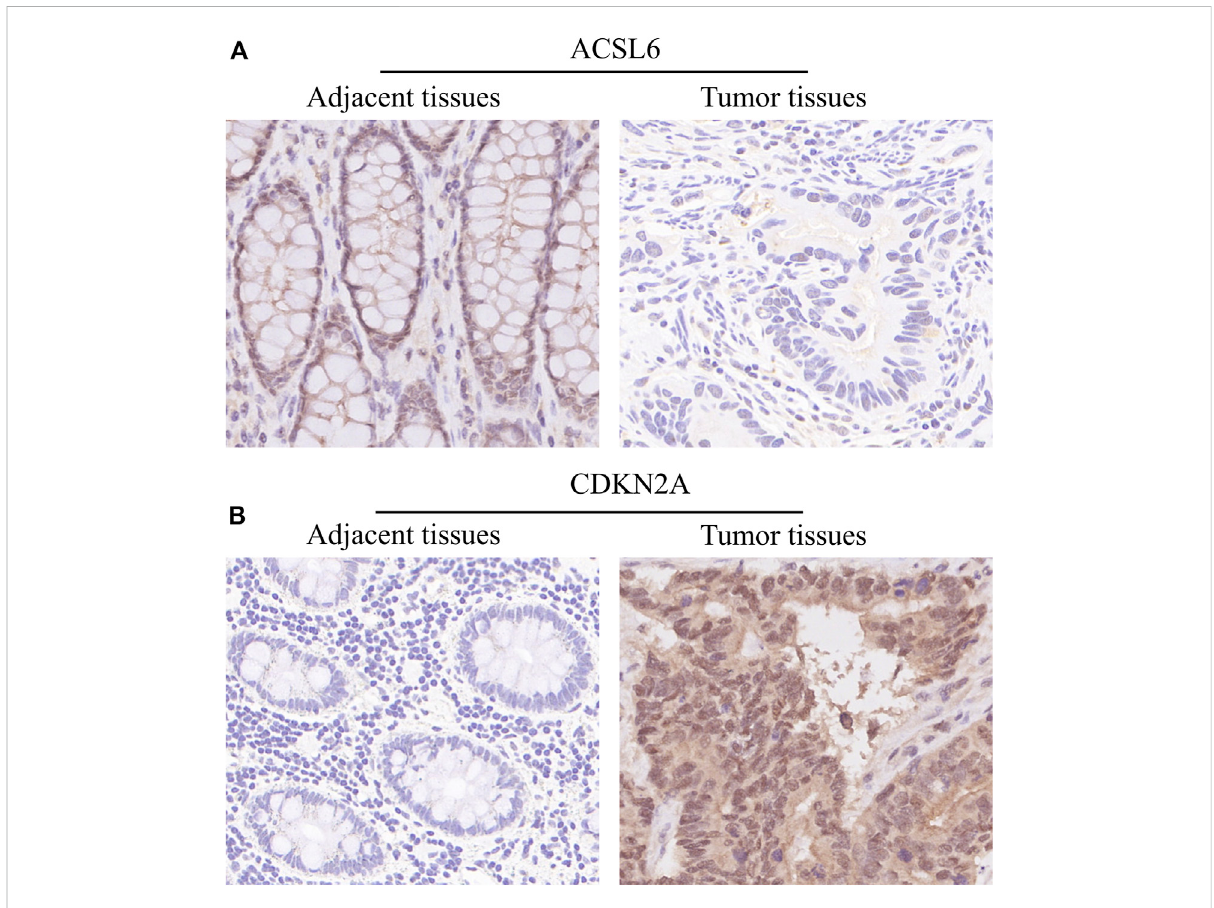
FIGURE 12 Verify the translational expression of ferroptosis-associated in CRC and normal tissues. (A) The representative images of ACSL6 in the adjacent tissues and tumor tissues. (B) The representative images of CDKN2A in the adjacent tissues and tumor